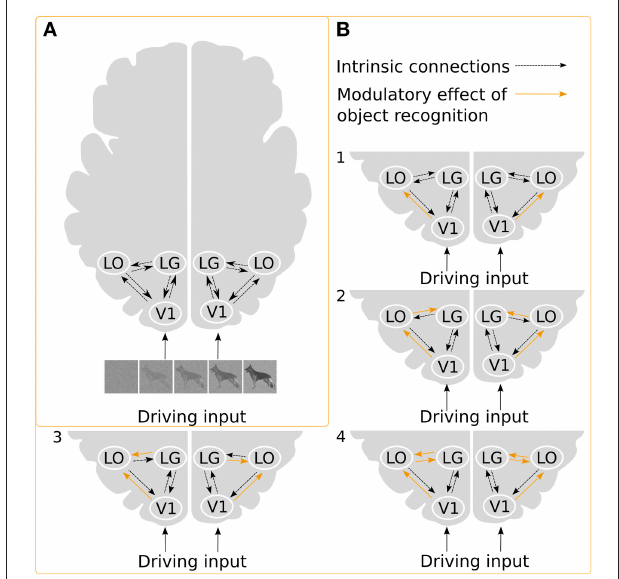
FIGURE 3 | Illustration of the DCMs. (A) Intrinsic connections and the driving input of the stimuli. (B) Examples of possible ways in which object recognition could modulate effective connectivity. In model 1, object recognition alters the connectivity from V1 to LO, and modulation of the intrinsic connection changes between LG and LO, in model 2, object recognition modulates connectivity from V1 to LO as well as from LO to LG, while in model 3, the connectivity from LG to LO is modulated. Finally, in model 4, modulations affect both directions between LG and